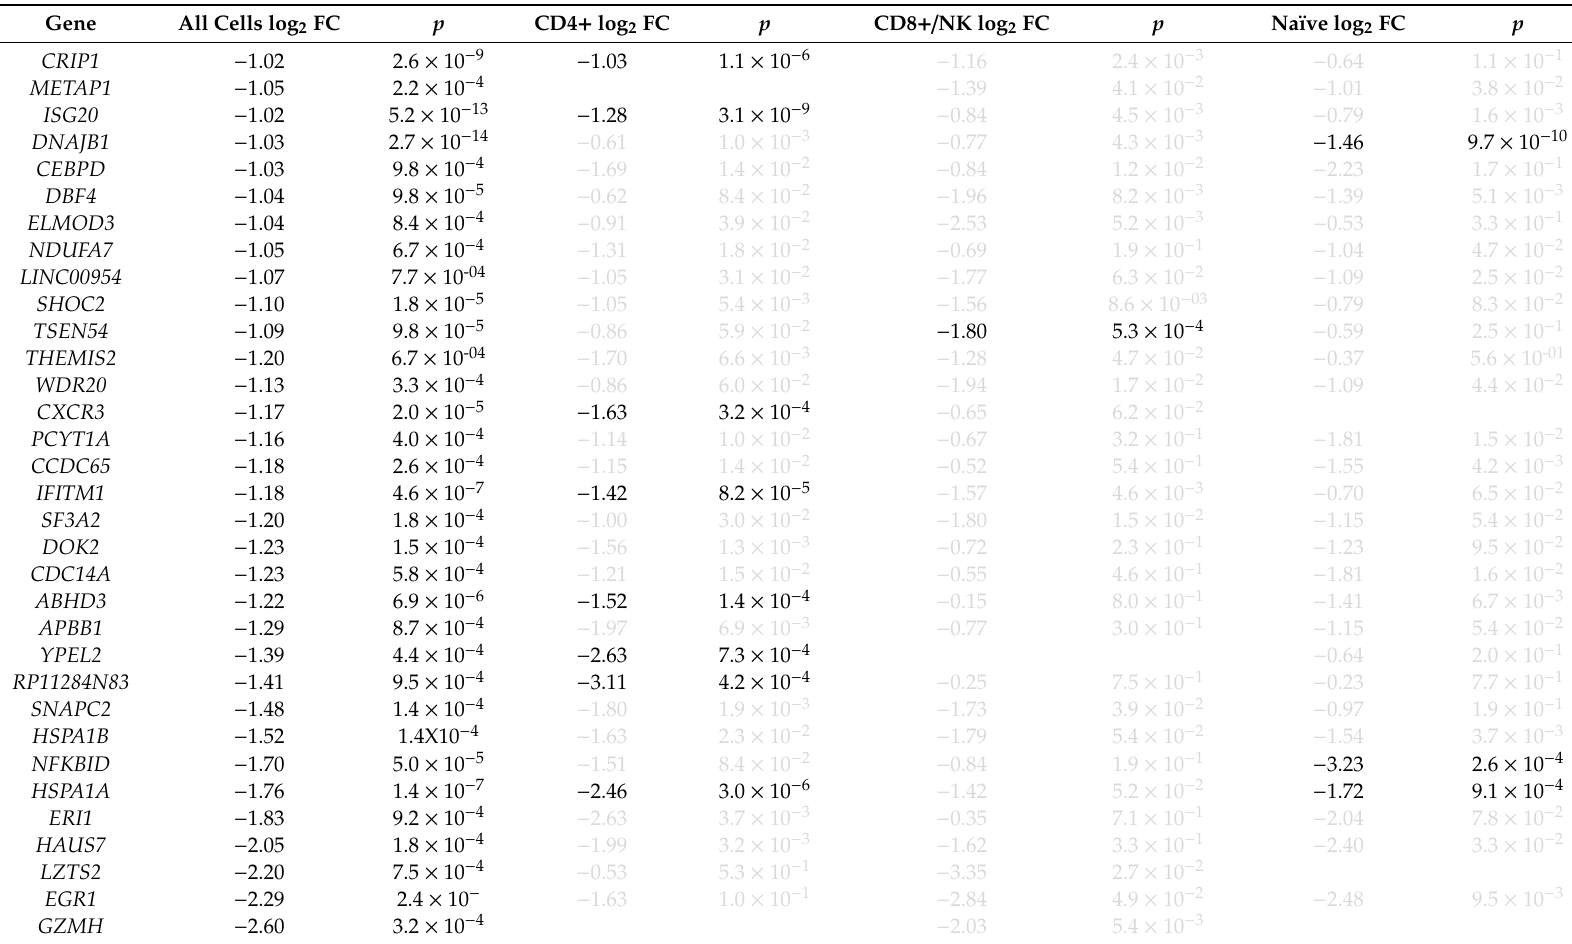
Table 3. Genes whose expressions were downregulated signicantly when all of the cells or cells in individual cell types were considered. The genes meet the criteria of Fold Change (FC) > 2 (log 2 FC < − 1) and p <